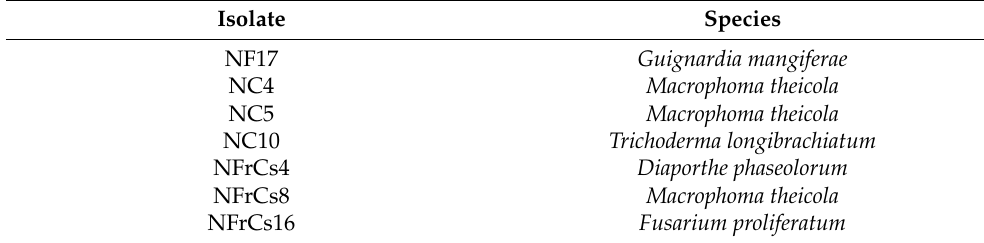
Table 2. Identification of the endophytic fungi of Morinda citrifolia . Isolate Species